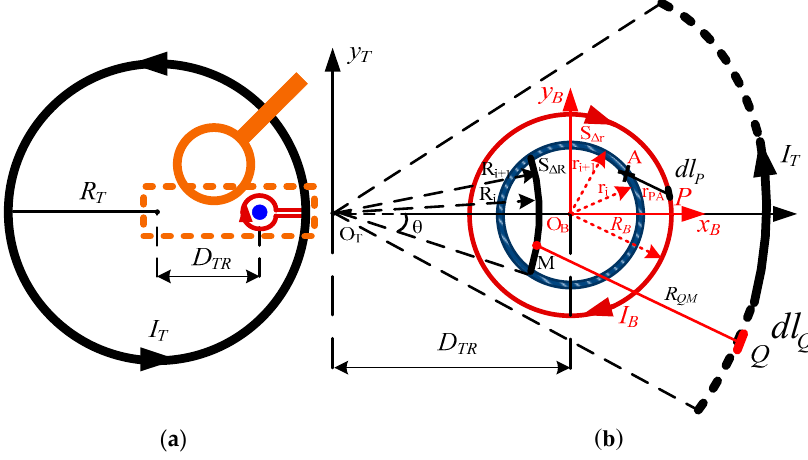
Figure 2. Top view of the suspension bracket and the magnetic field intensity. ( a ) Top view of the suspension bracket; ( b ) The magnetic field intensity of the suspension bracket.